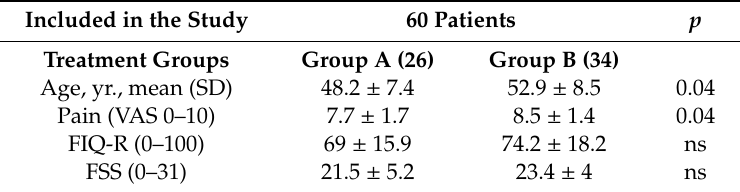
Table 1. Patient demographics and baseline characteristics.